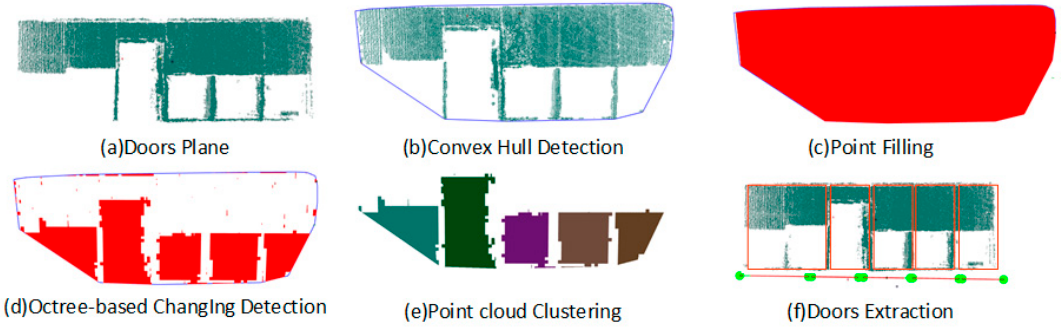
Figure 8. Generation of the opening components.